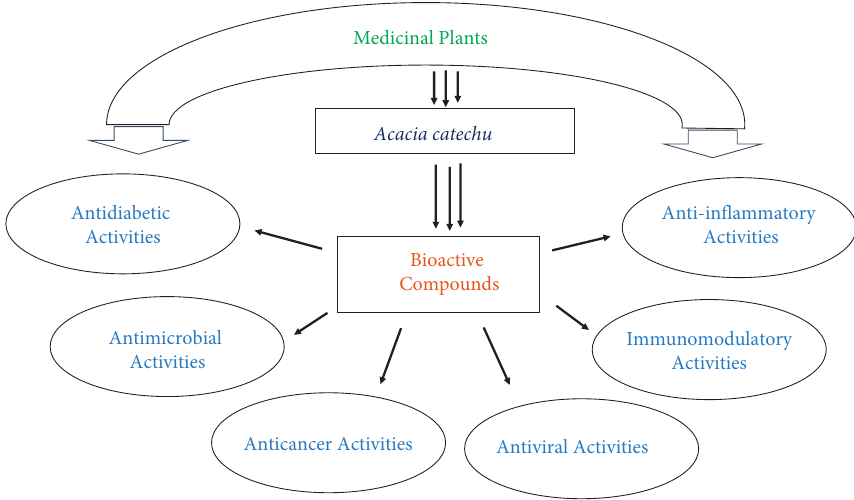
Figure 1: Pharmacological applications of Acacia catechu